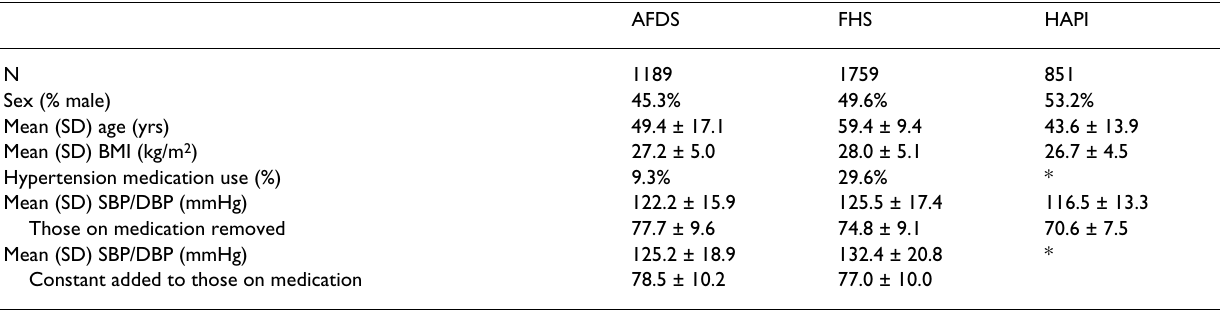
Table 1: Sample characteristics for the AFDS, FHS, and the HAPI Heart